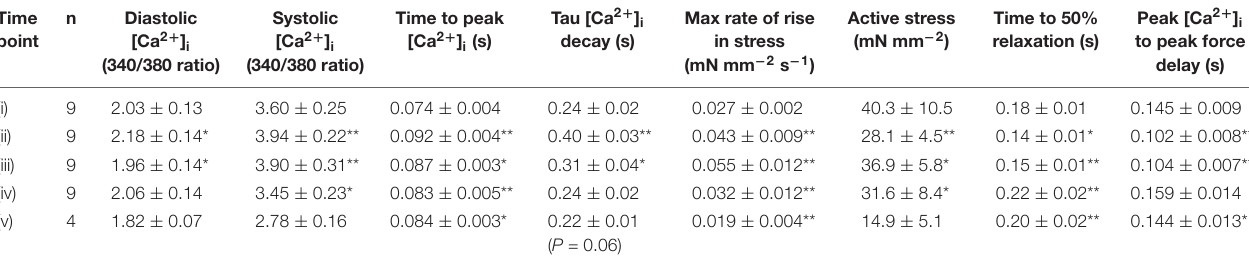
TABLE 1 | Mean ± SEM [Ca 2 + ] i transient (340/380 fura-2 ratio) and twitch force for the time points shown in Figure 1 : before (i), during (ii), immediately after (iii), 5 min after (iv), and 30 min after (v) formamide